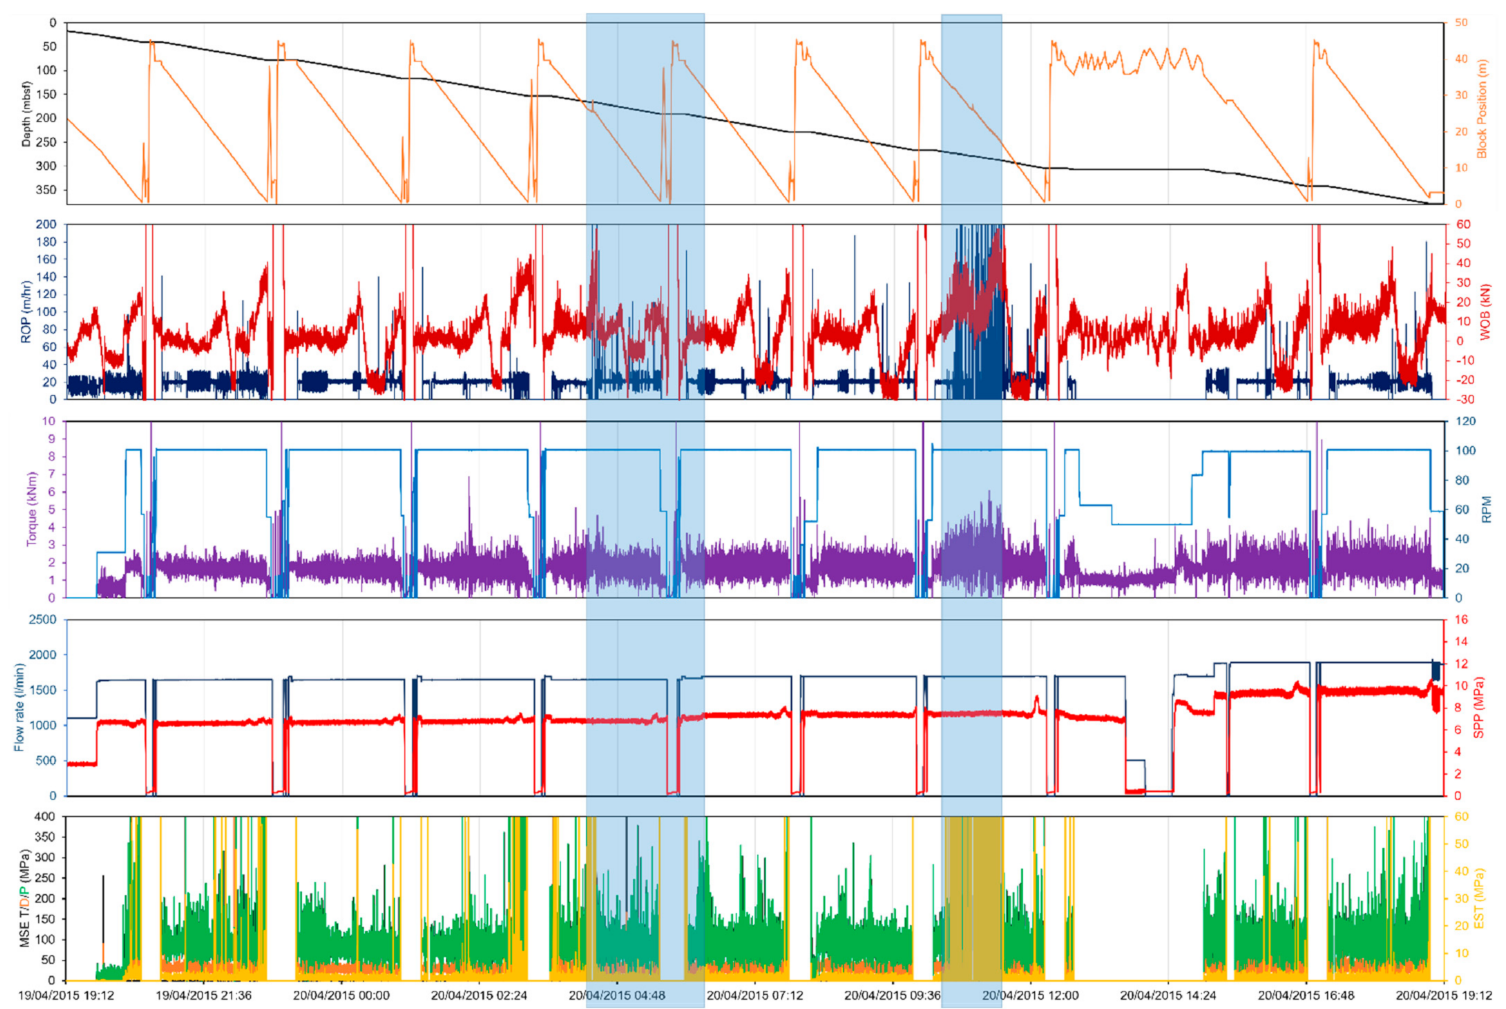
Figure 3. An example of recorded time-based drilling parameters together with calculated MSE/EST used for analysis for NGHP-02-23A well. Light blue shaded areas between 165.3–198.5 mbsf and 270–288.6 mbsf represent gas hydrate accumulations defined from seismic imaging and downhole